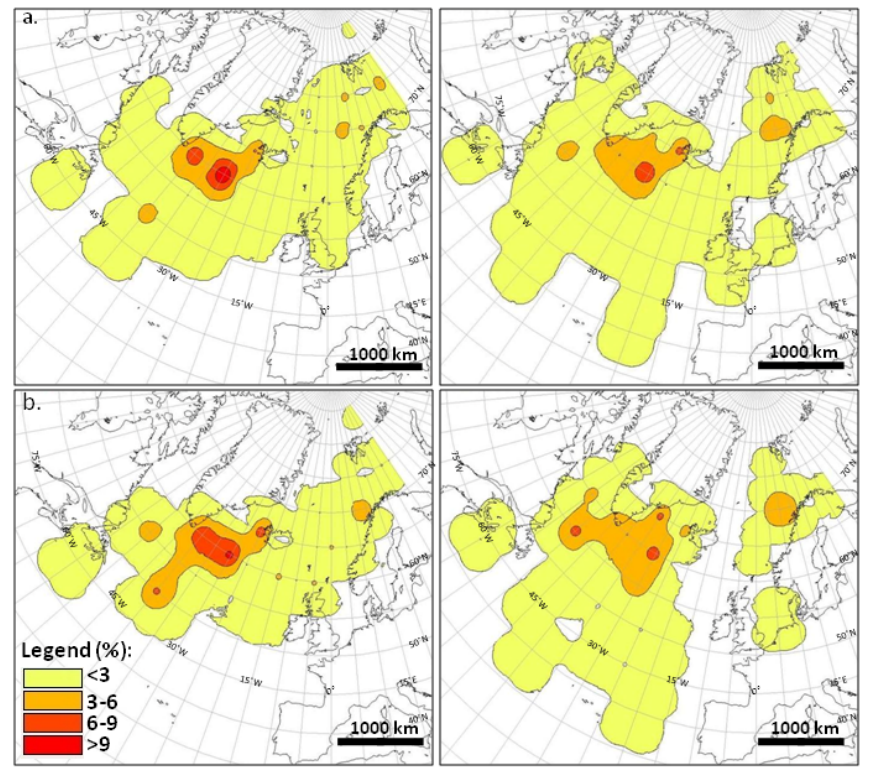
Figure 3. (a) Upper panel: relative frequency (%) of the lowest mean SLP occurring during high (left) and low (right) solar months for the cold season (October–March). (b) Lower panel: relative frequency (%) of the lowest mean SLP occurring during high (left) and low (right) solar months for winter